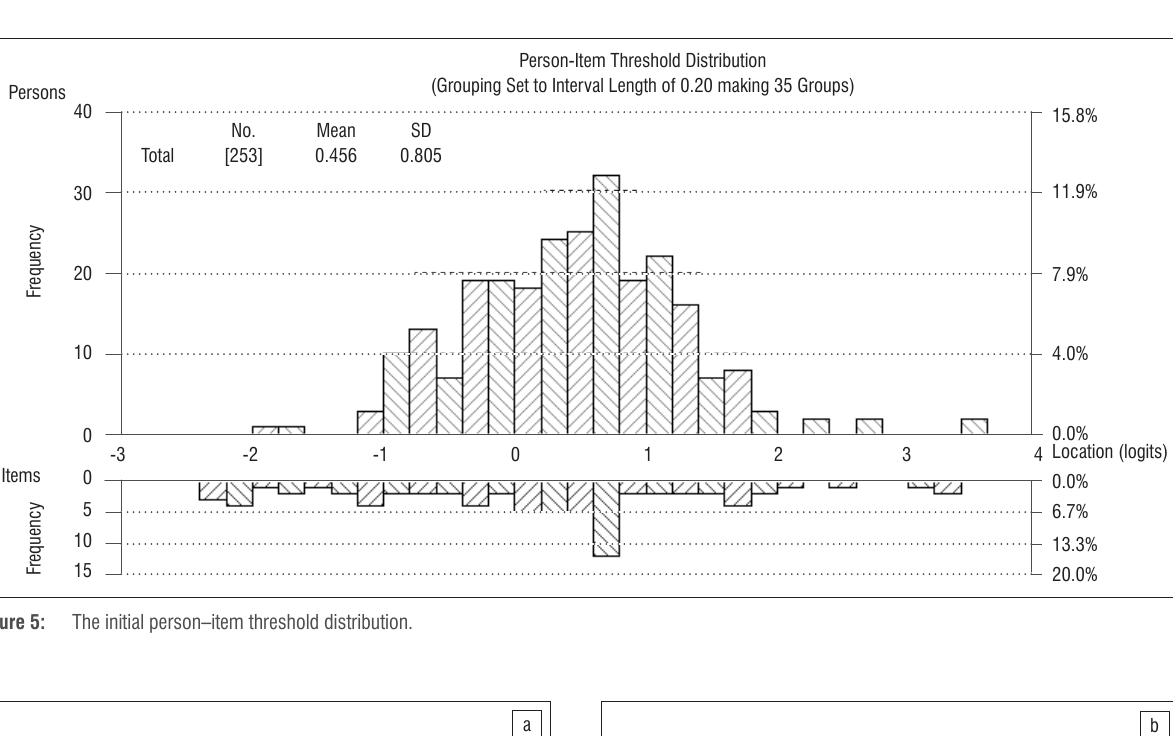
Figure 4: The initial person–item location distribution.